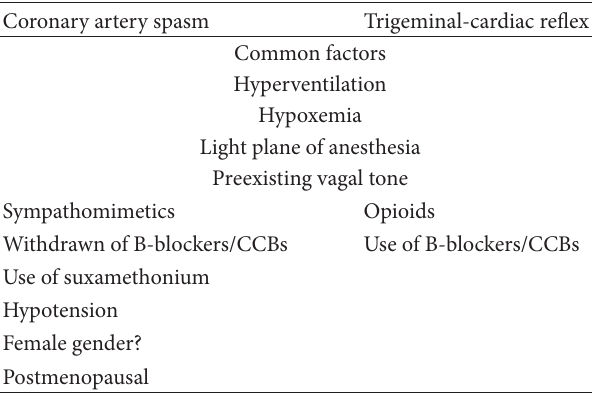
Table 2: Risk factors related to coronary artery spasm and trigeminal-cardiac